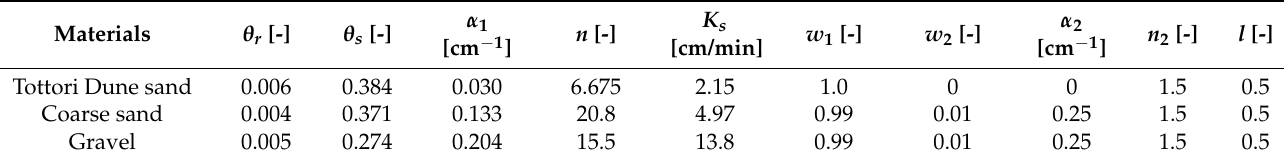
Table 1. It should be noted that the van Genuchten [30] model was applied for Tottori dune sand by setting the w 2 value to zero. Table 1. Initial estimates of the soil hydraulic parameters of Tottori Dune sand, coarse sand, and gravel for the Durner [29]